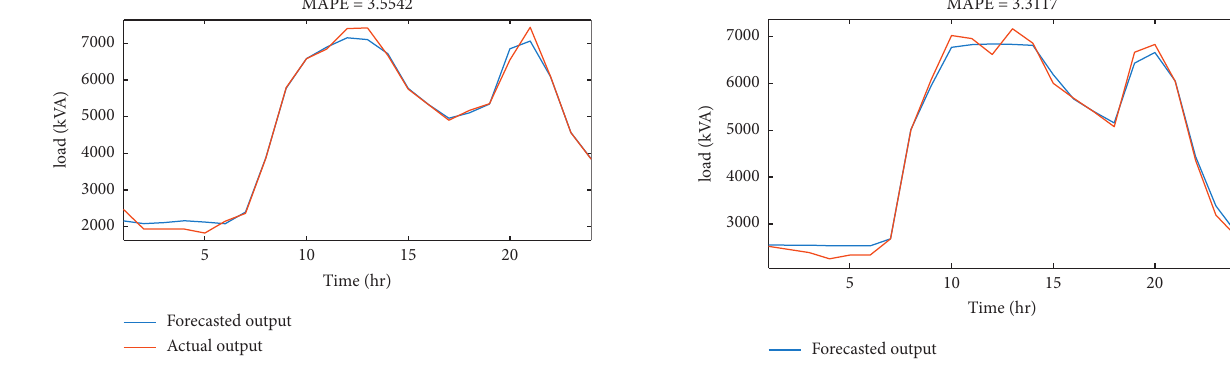
Figure 22: The Fuzzy-PSO prediction of Adwa load.